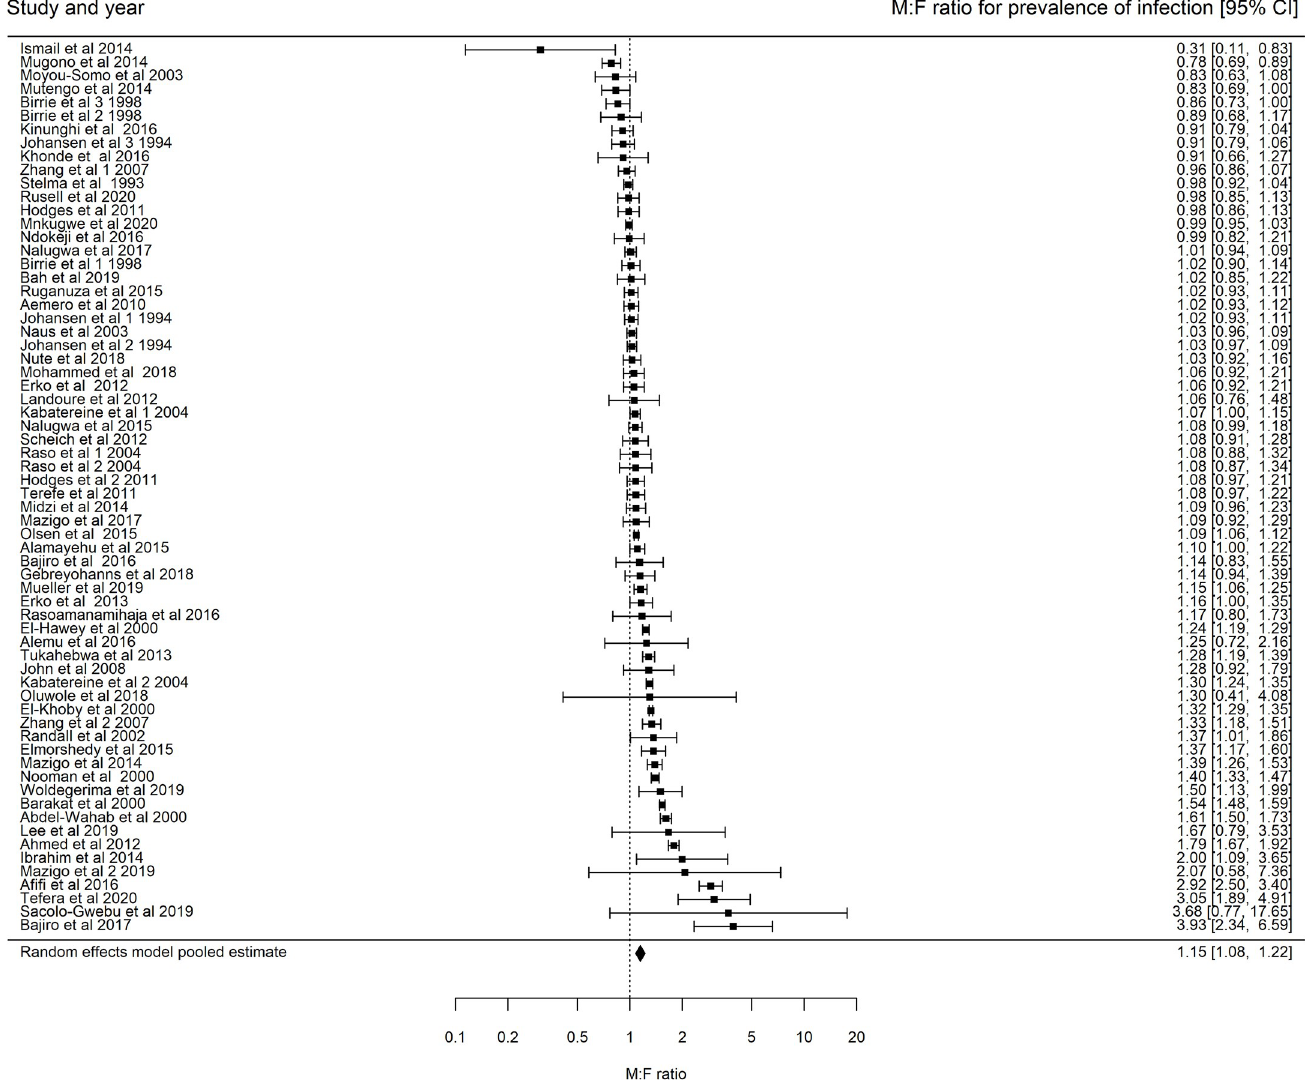
Fig 5. Forest plots showing the M:F prevalence of infection ratios and 95% CI for Schistosoma mansoni (66 communities and n = 61 studies, pooled M:F prevalence ratio is (1.15, 95% CI 1.08–1.22), heterogeneity: I 2 = 96.43%). Points further to the right indicate higher prevalence in males. Analysis includes studies that report the number of males and females who were screened for S. mansoni infection and the fraction who tested positive regardless of the reported significance of the difference in M:F prevalence of infection ratio.